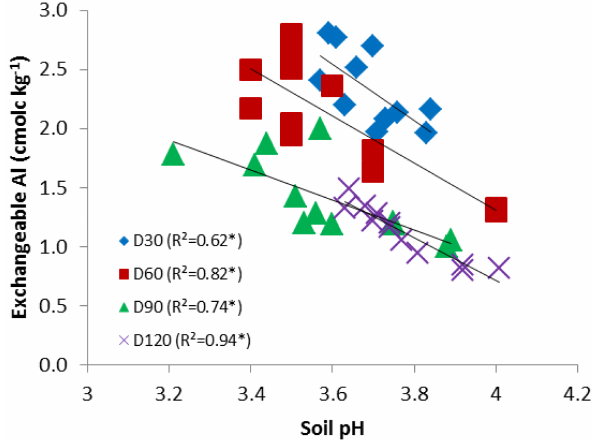
Figure 6. Relationship between Si content and soil pH throughout the incubation period ( ∗ p< 0 .